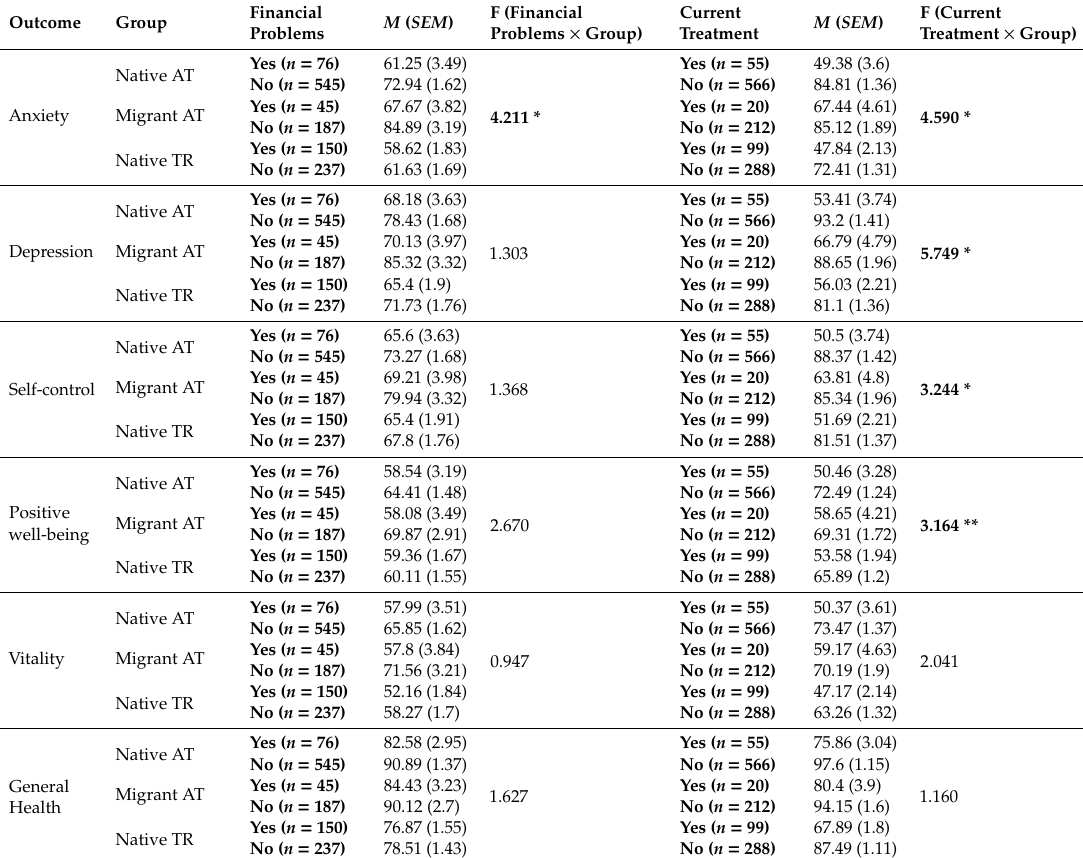
Table 1. MANCOVA results regarding group comparisons of the psychological general well-being index separately depicted with the factors financial problems and current